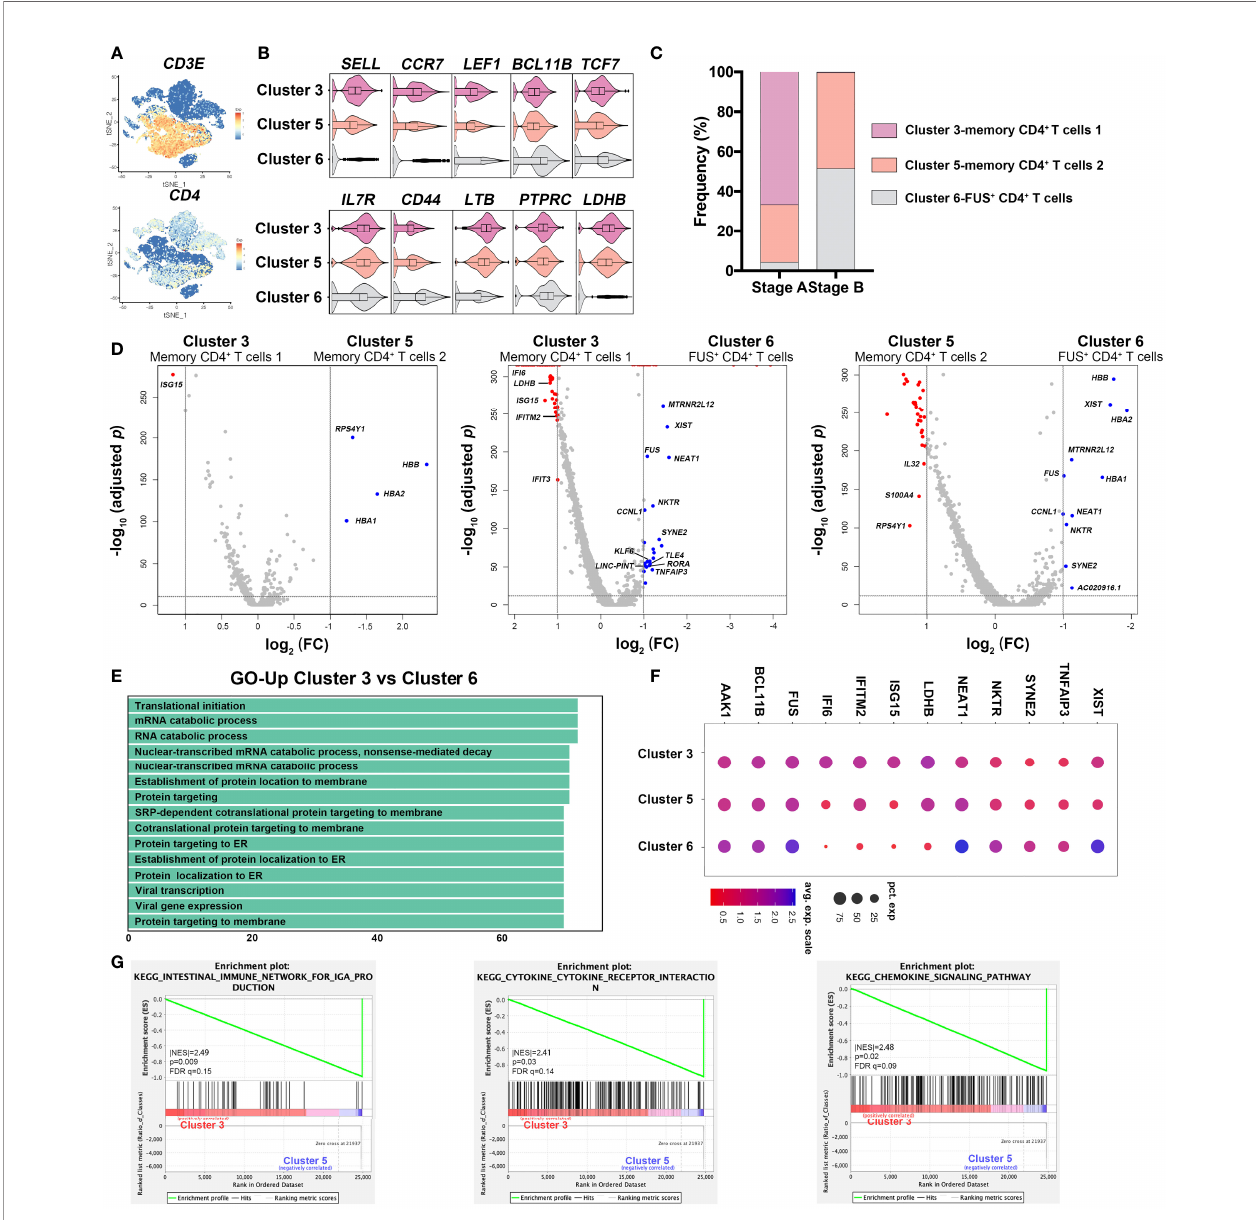
FIGURE 3 | Characterization of CD4 + T cells in different stages in COVID-19 patients. (A) Feature plots of characteristic genes of CD4 + T cells were represented via tSNE. (B) Genotypes of three CD4 + T cell subsets, namely, Cluster 3 (memory CD4 + T cells 1), Cluster 5 (memory CD4 + T cells 2), Cluster 6 (XIST + CD4 + T cells). (C) Frequency distribution of the three CD4 + T cell clusters in each stage. (D) Volcano plots of Cluster 3 (memory CD4 + T cells 1) versus Cluster 5 (memory CD4 + T cells 2), Cluster 3 (memory CD4 + T cells 1) versus Cluster 6 (XIST + CD4 + T cells), and Cluster 5 (memory CD4 + T cells 2) versus Cluster 6 (XIST + CD4 + T cells). Differentially expressed genes were de fi ned with threshold of fold change ≥ 2 and p-value <0.05 and represented as red or blue. (E) GO analysis with genes highly expressed in Cluster 3 comparing with Cluster 6. (F) Signature genes generated from differential gene expression analysis. Size and color of dots are related with counts of gene expression. Bigger and bluer dots represent higher gene expression. (G) Gene sets enrichment analysis (GSEA) between Cluster 3 (memory CD4 + T cells 1) and Cluster 5 (memory CD4 + T cells 2). Cluster 5 had genes enriched in “ intestinal immune for IgA production, ” “ cytokine – cytokine receptor interaction, ” and “ chemokine signaling pathway. ” Signi fi cant enrichment was de fi ned by |NES| > 1, NOM p-val < 0.05, FDR q <